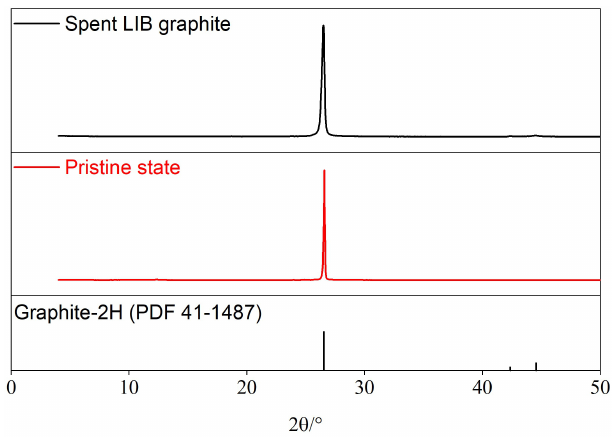
Figure 11. Comparisons of the XRD pa(cid:308)erns of unused (pristine state) and used graphite electrode materials.